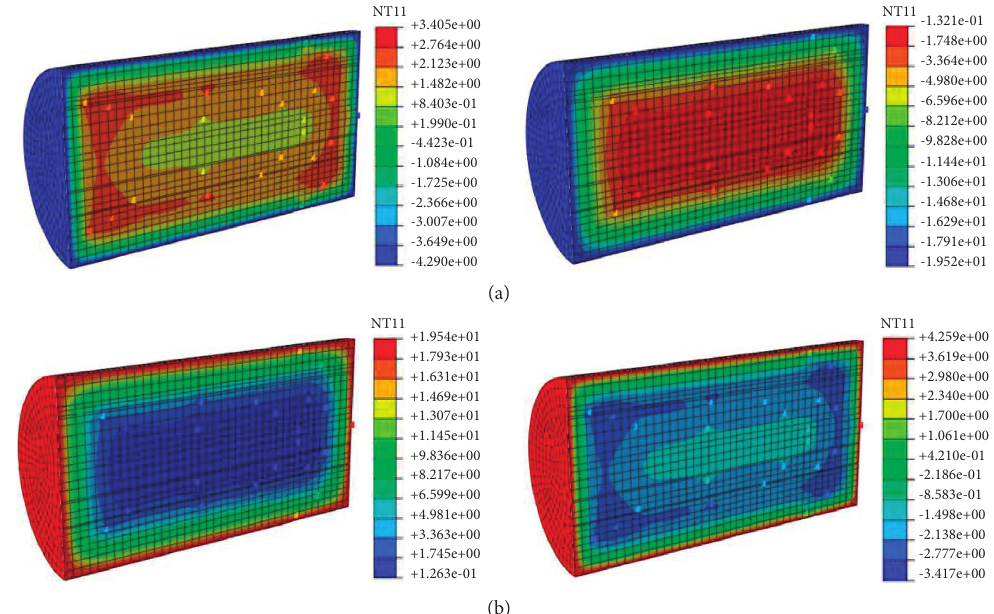
Figure 33: Grid division diagram of structural model. (a) Cloud picture of freezing process change. (b) Cloud picture of melting process